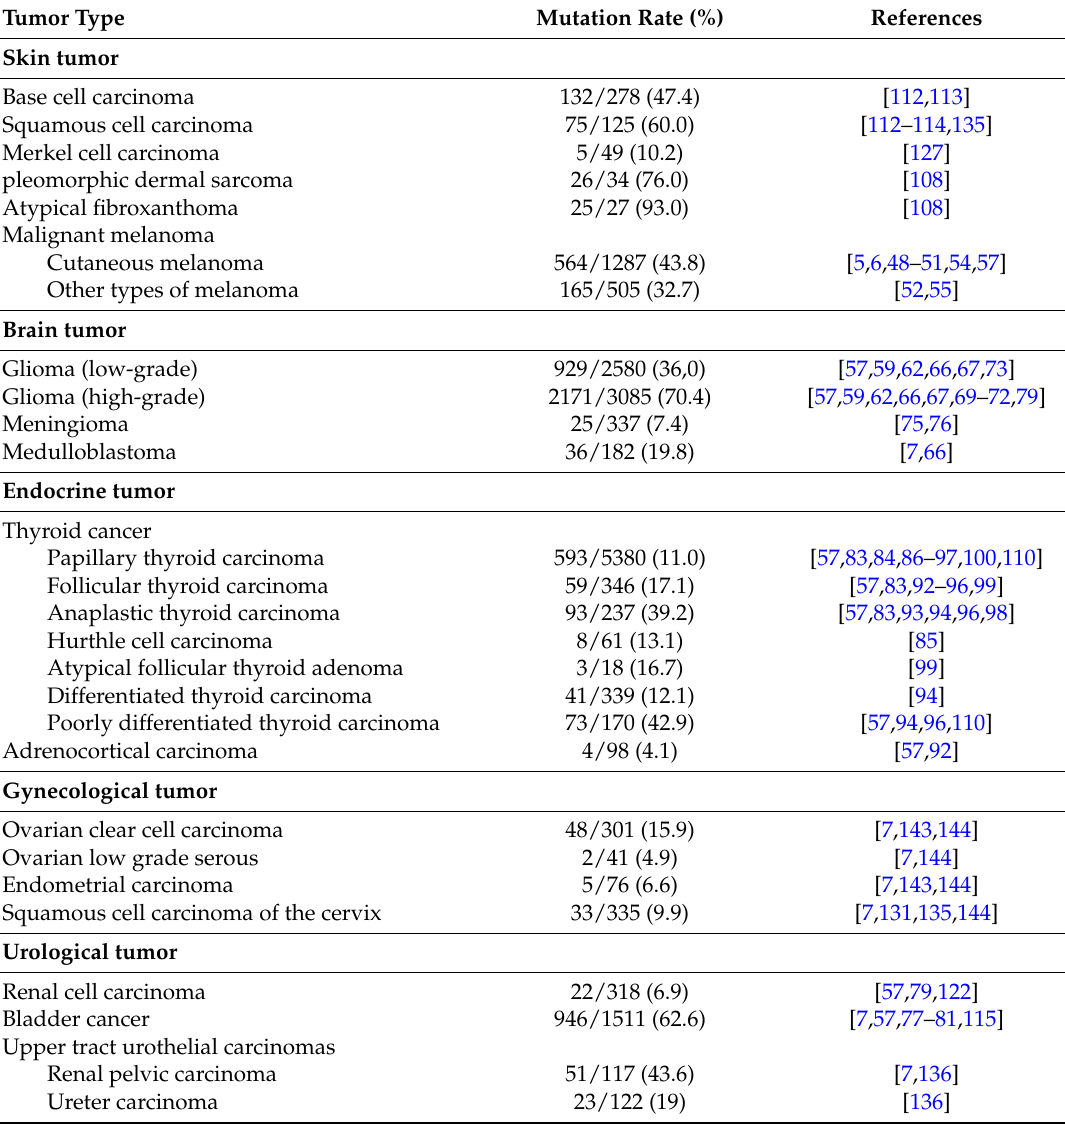
Table 1. A Summary of TERT promoter mutations in human